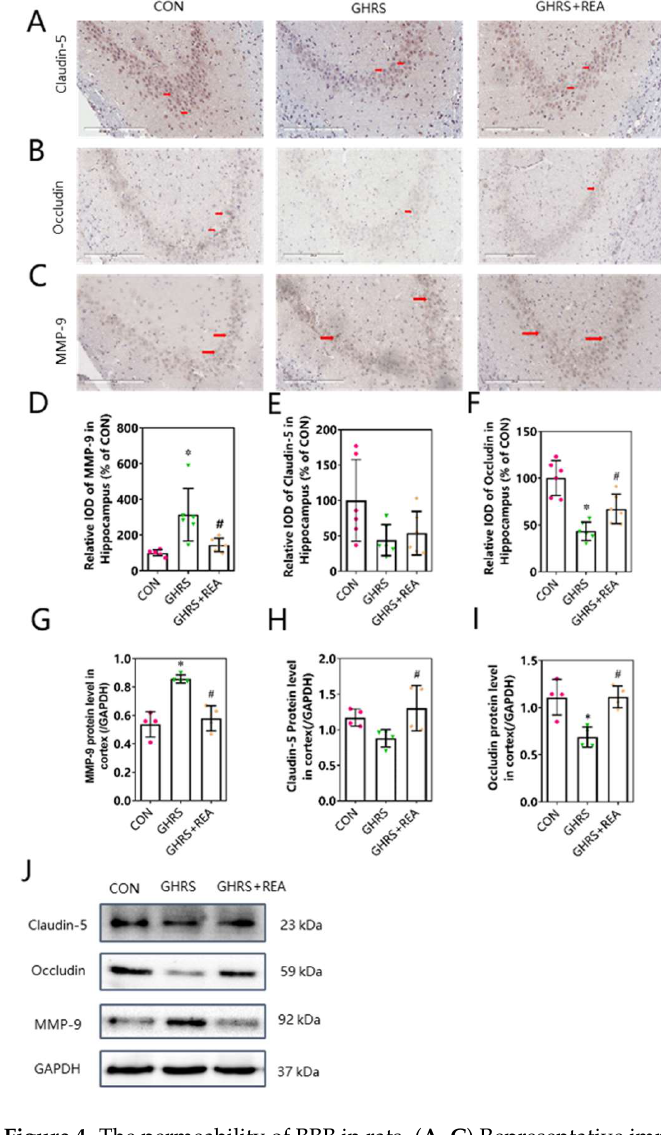
Figure 4. The permeability of BBB in rats. ( A – C ) Representative immunohistochemistry photographs showing Claudin-5, Occludin, and MMP-9 expression in the hippocampus of rats. ( D – F ) The protein expression of MMP-9, Claudin-5, and Occludin in the hippocampus, n = 6. ( G – I ) The protein levels of Claudin-5, Occludin, and MMP-9 in the cortex, n = 4. ( J ) The protein bands of Claudin-5, Occludin, and MMP-9 in the cortex. Each column shows the mean ± SD. * p < 0.05 compared with CON group, # p < 0.05 compared with GHRS group.